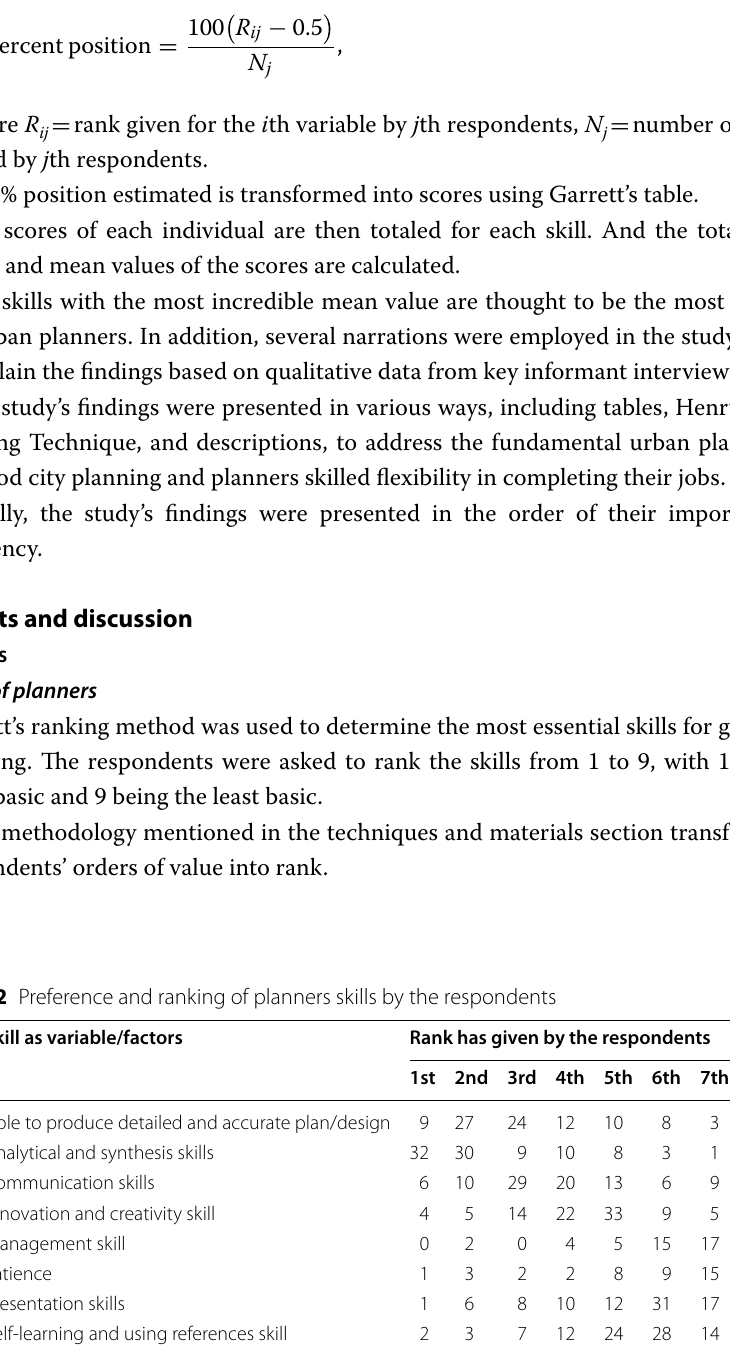
Source: Field survey, 2021